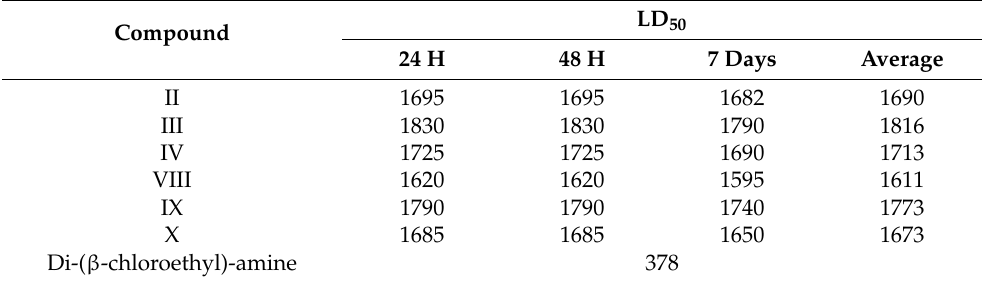
Table 8. The LD50 values (mg/kg body weight) for the compounds II–IV, VIII–X.